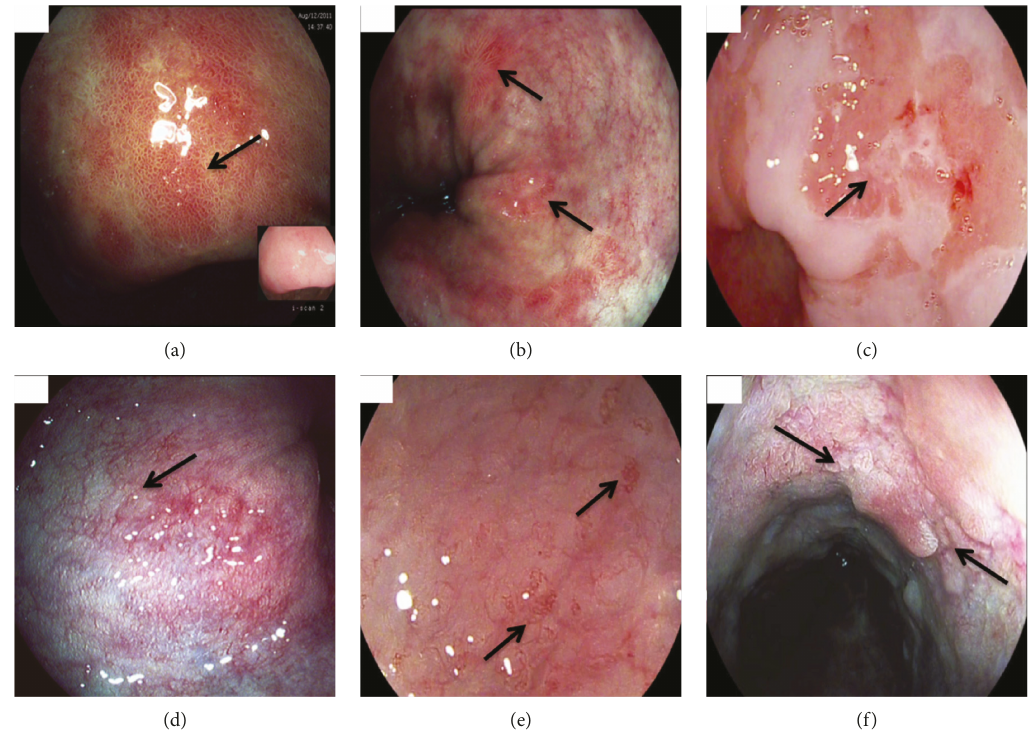
Figure 2: Endoscopic appearances of di ff erent mucosal, microvascular patterns, and architecture of Barrett ’ s segment using i-Scan. Arrows denote particular areas of interest. (a) M1: regular circular, oval pits; (b) M1: villous/gyrus ridged pits; (c) M2: distorted, featureless mucosa with surface ulceration; (d) V1: regular uniform vessels; (e) V2: irregular, “ corkscrew-like ” vessels; (f) nodularity with surrounding distortion of the normal mucosal surface